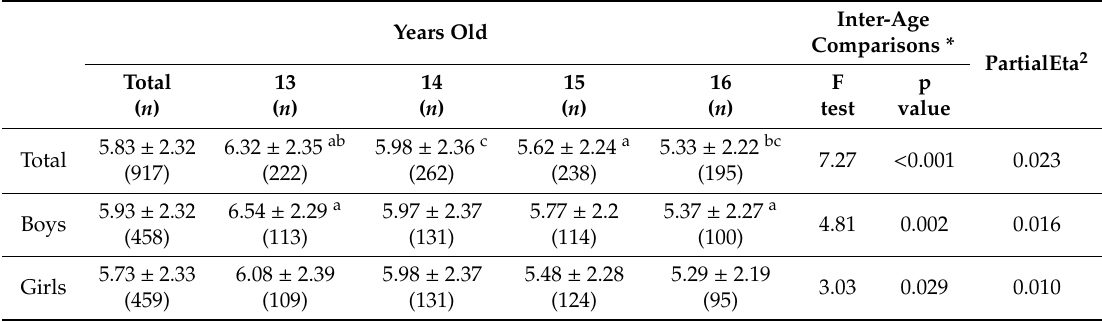
Inter-age Comparisons* PartialEta 2